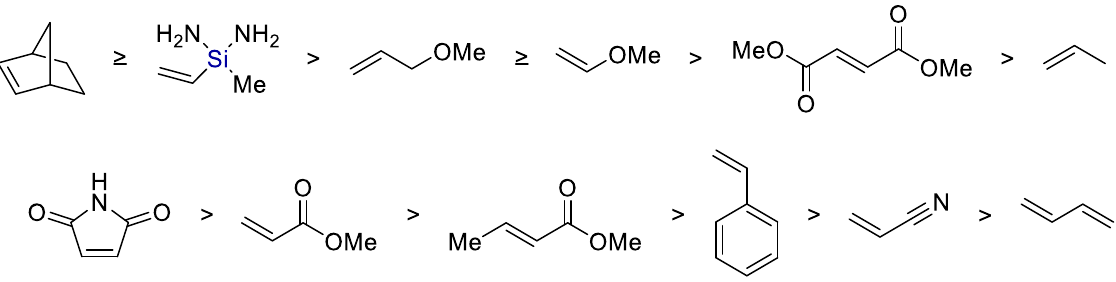
Figure 5. The predicted order of alkene reactivity with methyl mercaptan: norbornene ≥ vinyl silane > allyl ether ≥ vinyl ether > fumarate > propene > maleimide > methacrylate > crotonate > styrene > acrylonitrile > butadiene [20]. Adopted from Ref.